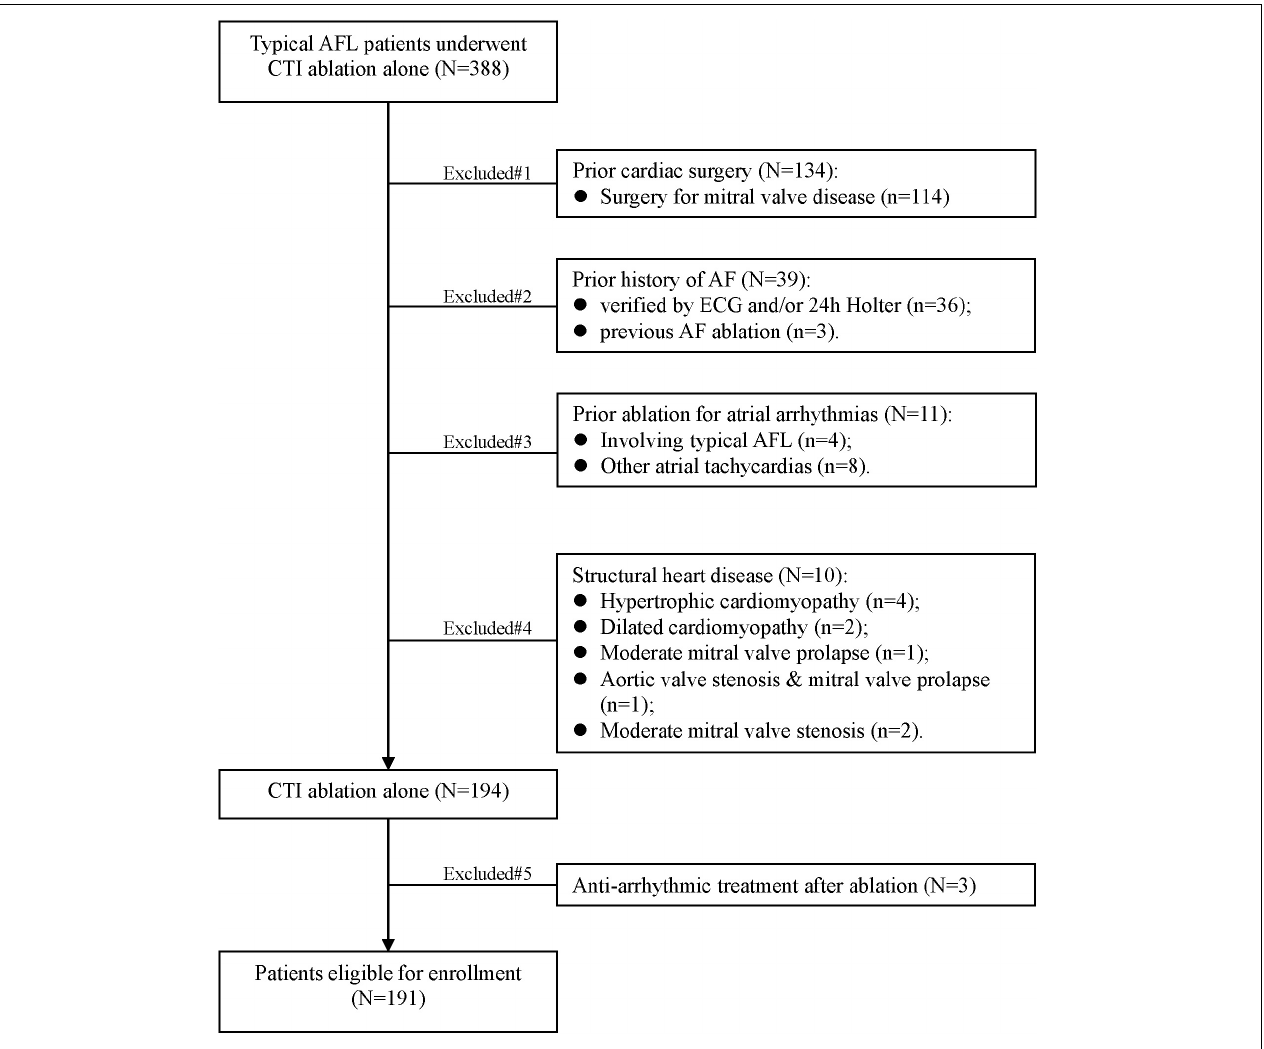
FIGURE 1 | Flowchart of this study. AF, atrial fibrillation; AFL, atrial flutter; CTI, cavotricuspid isthmus.